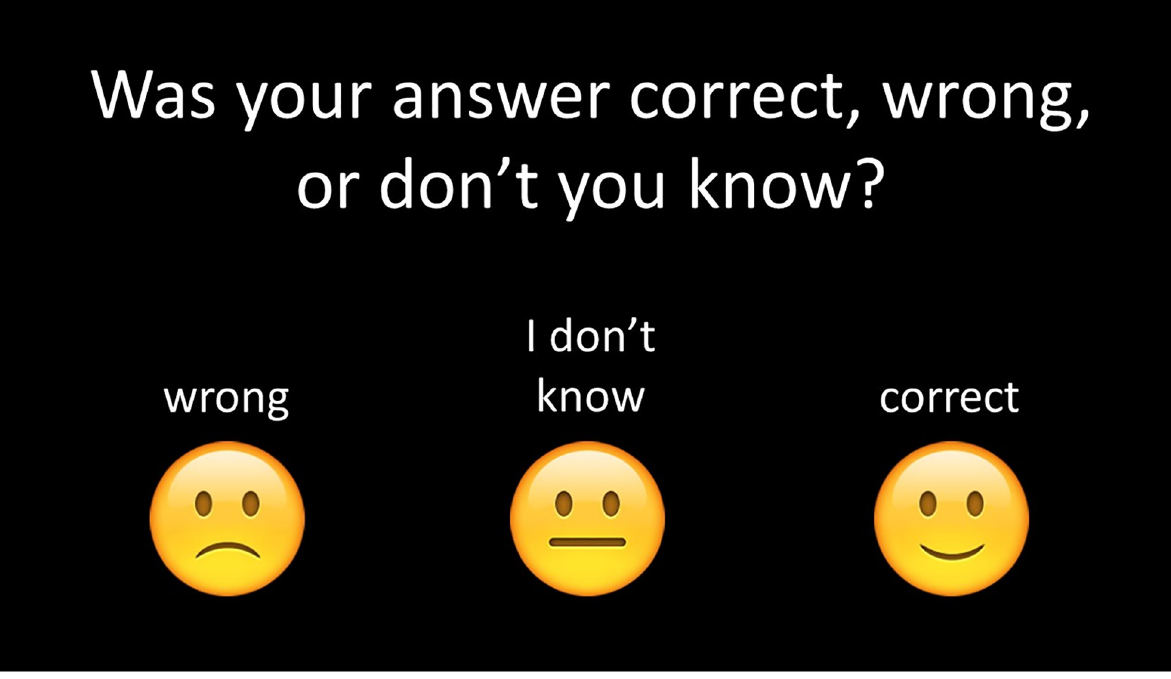
Fig 1. Example of metacognitive monitoring question after arithmetic/spelling